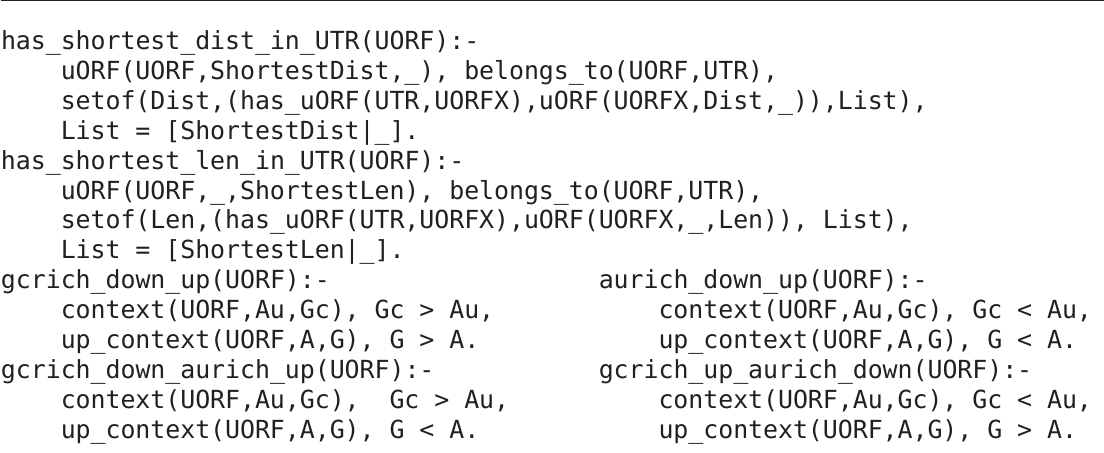
Table 4: Intensional Background Knowledge